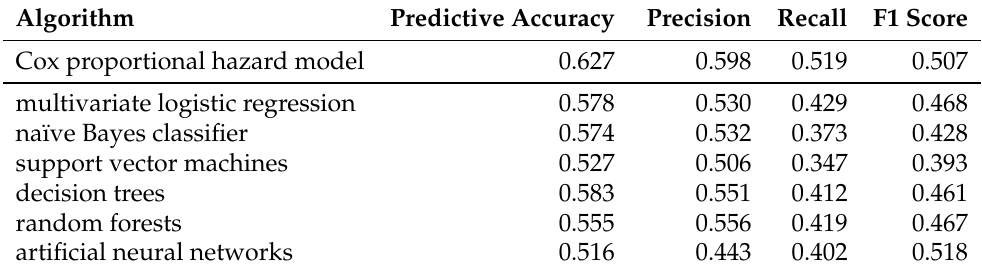
Table 4. Predictive accuracy, precision, recall and F1 score of COVID-19 IgM antibody blood level decrease below laboratory cut-off’s estimation for the listed algorithms, both traditional Cox’s model and classifiers using a decomposed time-to-event variable, calculated using 10-fold